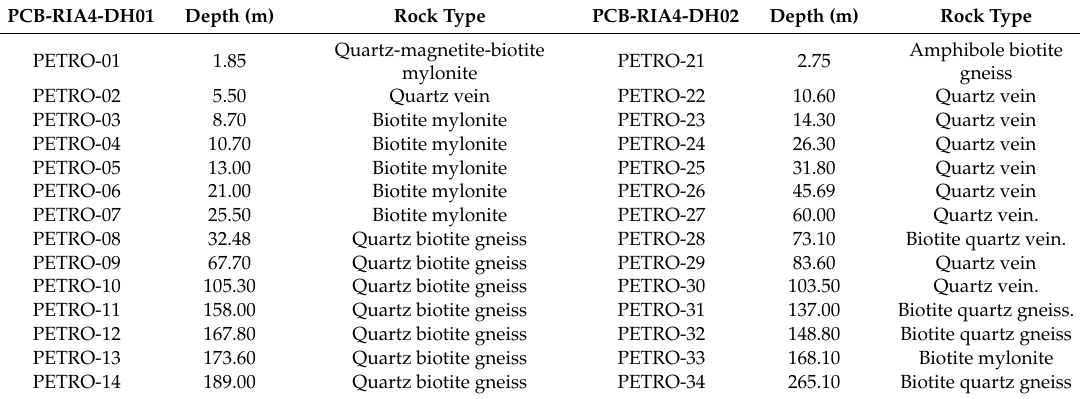
Table 1. Rock types and depths of samples from the Riacho do Pontal copper district sampled from two drill holes (PCB-RIA4-DH01 and PCB-RIA4-DH02).